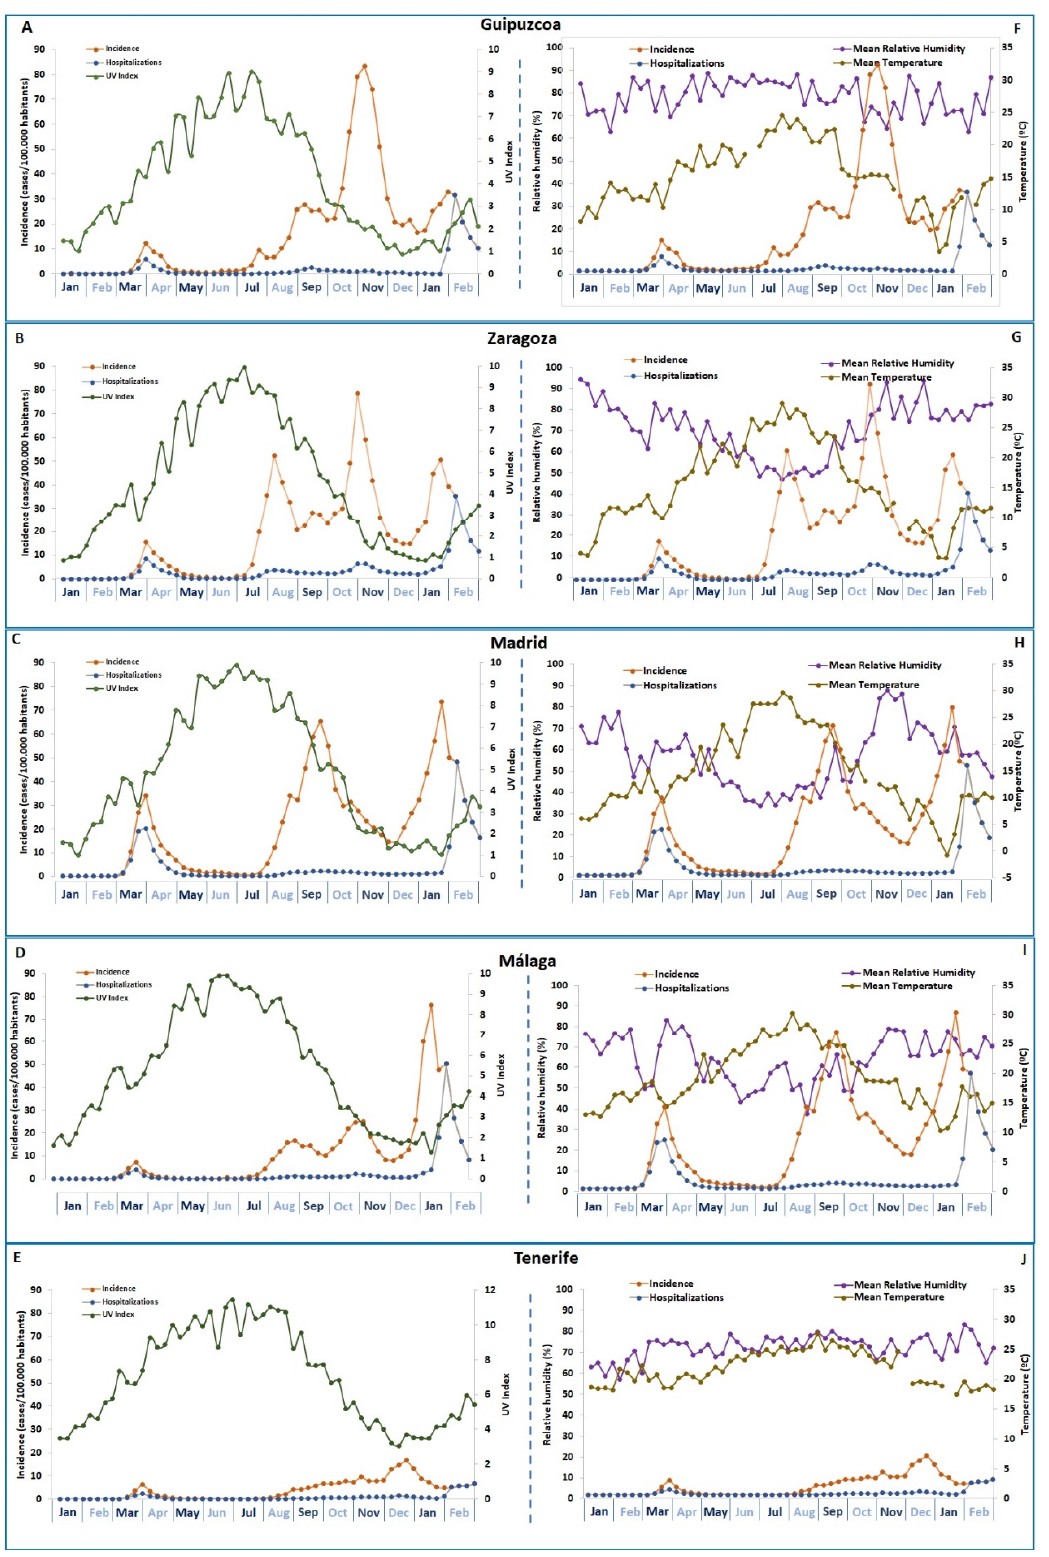
Figure 1. ( A – E ) Seasonal variations of mean weekly UVI, COVID-19 incidence rate, and hospitalized cases, with ( F – J ) seasonal variations of mean weekly temperature and humidity data for the same locations. COVID-19 incidence rates are also included in ( F – J ), to allow better observation of seasonal cycles of meteorological conditions related to COVID-19.